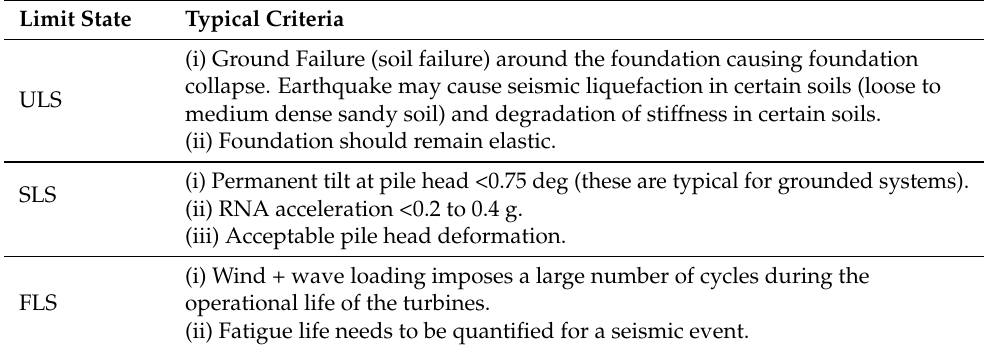
Table 3. ULS and SLS